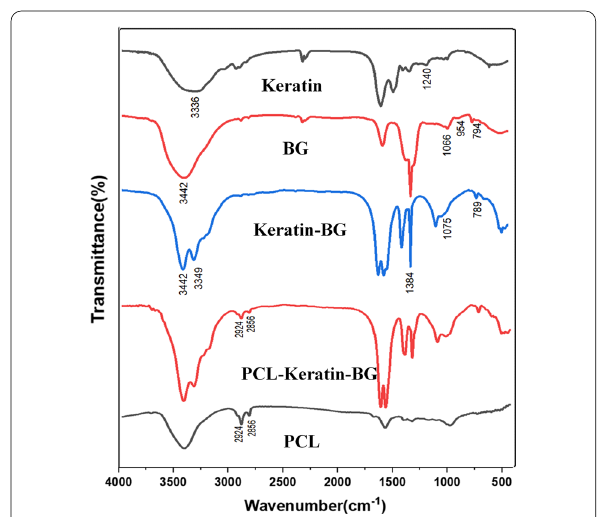
Fig. 3 FTIR spectra of BG, PCL, and keratin-BG and PCL-keratin-BG